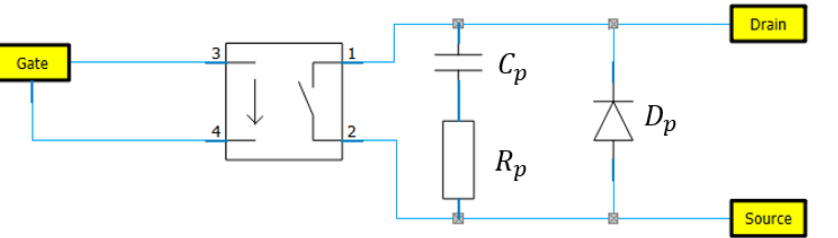
Figure 16. Equivalent circuit model of the mounted transistor. The parameter values are comprised in Table 3.